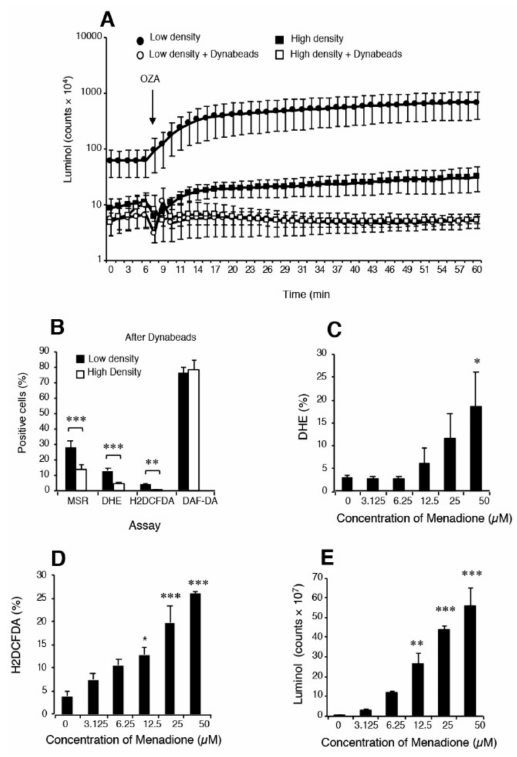
Figure 2. Analysis of spontaneous ROS generation by spermatozoa isolated from the high and low density regions of Percoll gradients. ( A ) Although luminol–horse radish peroxidase (HRP) dependent chemiluminescence could di ff erentiate between high- (functional) and low- (dysfunctional) density sperm populations, such discrimination was completely lost when leukocytes were removed using CD45-coated Dynabeads; n = 6. ( B ) Following the removal of contaminating leukocytes, several ROS sensitive probes (MSR, DHE and H2DCFDA) but not the NO probe, DAF-DA, could discriminate the di ff erences in sperm quality associated with high and low density Percoll populations. The most e ff ective probe in this context was MSR, in keeping with the key role that mitochondria play in the aetiology of defective sperm function; n = 12. If leukocyte-free sperm suspensions were triggered to generate significant ROS using the redox cycling quinone, menadione (vitamin K), then several of the probes used in diagnostic andrology including MSR (not shown) ( C ) DHE, ( D ) H2DCFDA, and even ( E ) luminol / peroxidase could clearly detect a dose-dependent redox signal. Indeed, these dose-dependent analyses reveal that luminol and H2DCFDA were actually more sensitive than DHE in this regard. Overall, this analysis suggests that while probes such as luminol / peroxidase can clearly detect extracellular ROS generation, in practice their output is heavily influenced by the presence of contaminating leukocytes. Detecting di ff erences in the spontaneous redox activity of the spermatozoa can, as indicated in panel B, only be achieved by flow cytometry using probes such as MSR, DHE and H2DCFDA (136). In panels ( A , E ), the chemiluminescence results are presented as counts per minute generated by the luminometer’s photomultiplier while in panels ( B – D ), the results are presented as the percentage of the sperm population exhibiting a positive response by flow